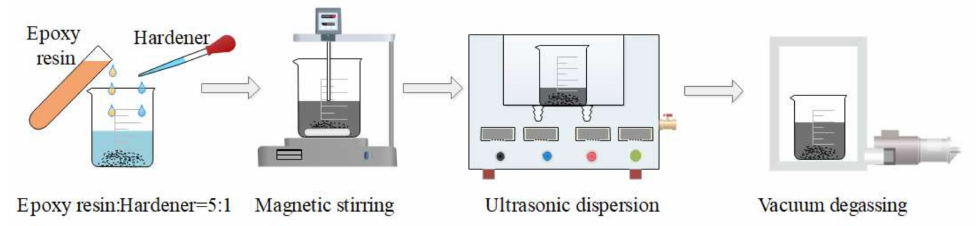
Figure 2. Preparation process of mixed solution of GO and epoxy